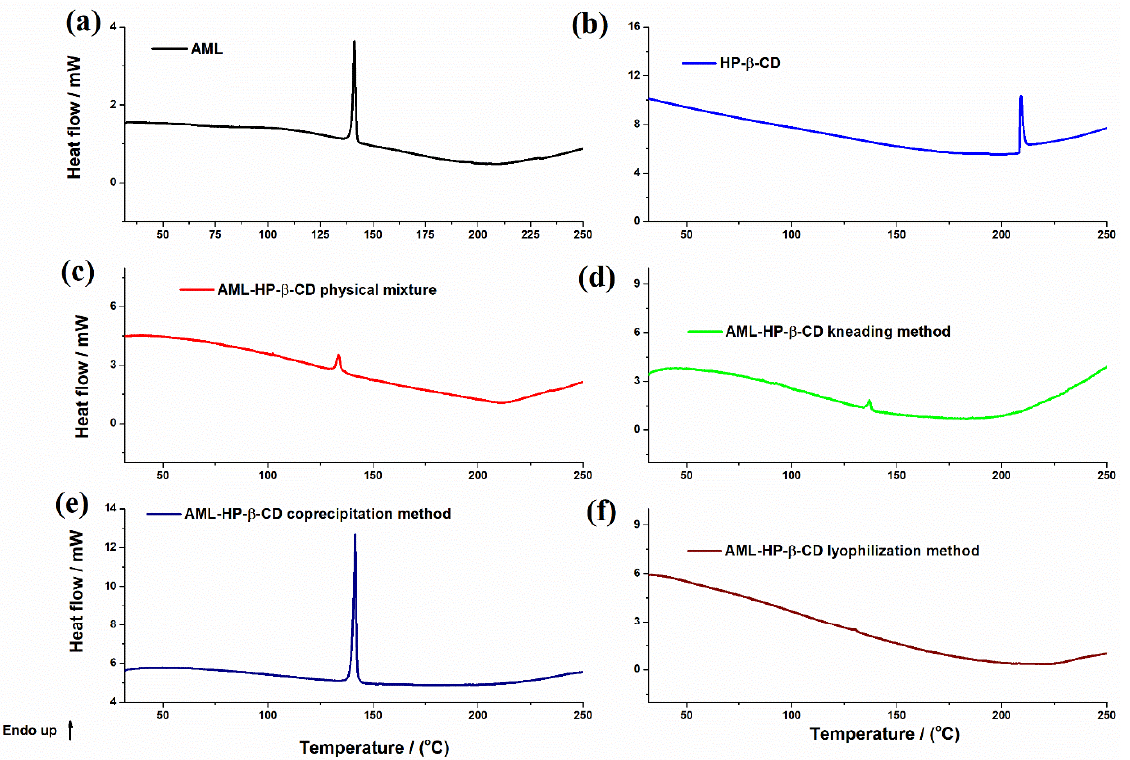
Figure 7. DSC curves of ( a ) AML, ( b ) HP- β -CD, ( c ) AML-HP- β -CD physical mixture, ( d ) AML-HP- β -CD kneading method, ( e ) AML-HP- β -CD coprecipitation method, and ( f ) AML-HP- β -CD lyophilization method.